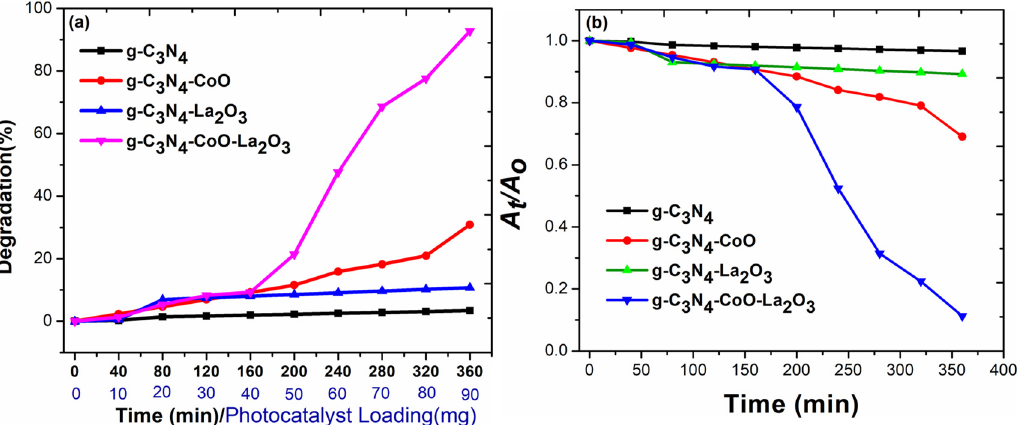
Figure 6. Photocatalytic degradation studies performed in 5 ppm methylene blue for g-C 3 N 4 , La 2 O 3 –g-C 3 N 4 , CoO–g-C 3 N 4 , and La 2 O 3 –CoO–g-C 3 N 4 nanocomposites, ( a ) % photodegradation vs. light exposure time and photocatalyst loading, ( b ) absorbance efficiency of MB upon addition of 10 mg each photocatalyst vs. time of visible-light